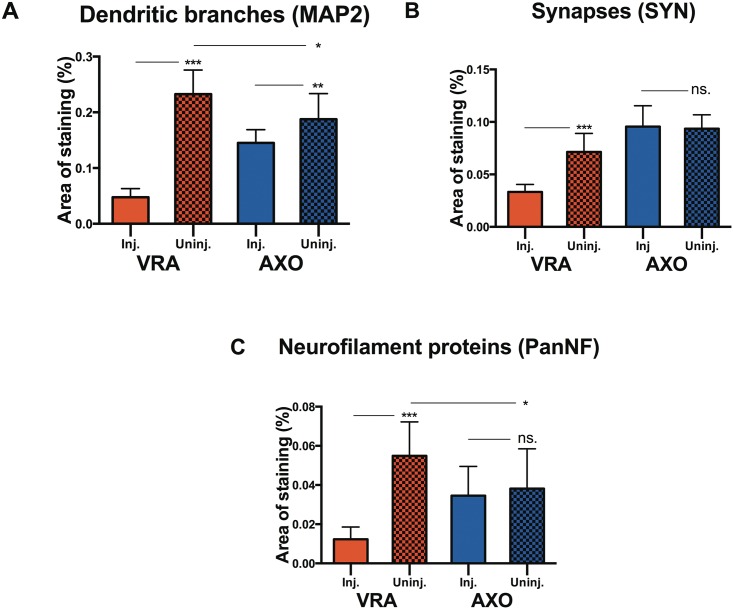
Quantification of dendrites, synapses & axons.Histogram showing the relative tissue area occupied by MAP2-positive dendritic branches (A), synaptophysin-positive synaptic boutons (B) and neurofilament-positive nerve fibers (C) in the L4-L5 segments of the spinal cord 4 weeks after ventral root avulsion (VRA) or axotomy (AXO) on the injured (inj.) and uninjured side (uninj.). Error bars show S.E.M. P<0.05 is indicated by *, p<0.01 is indicated by ** and p<0.001 is indicated by ***.